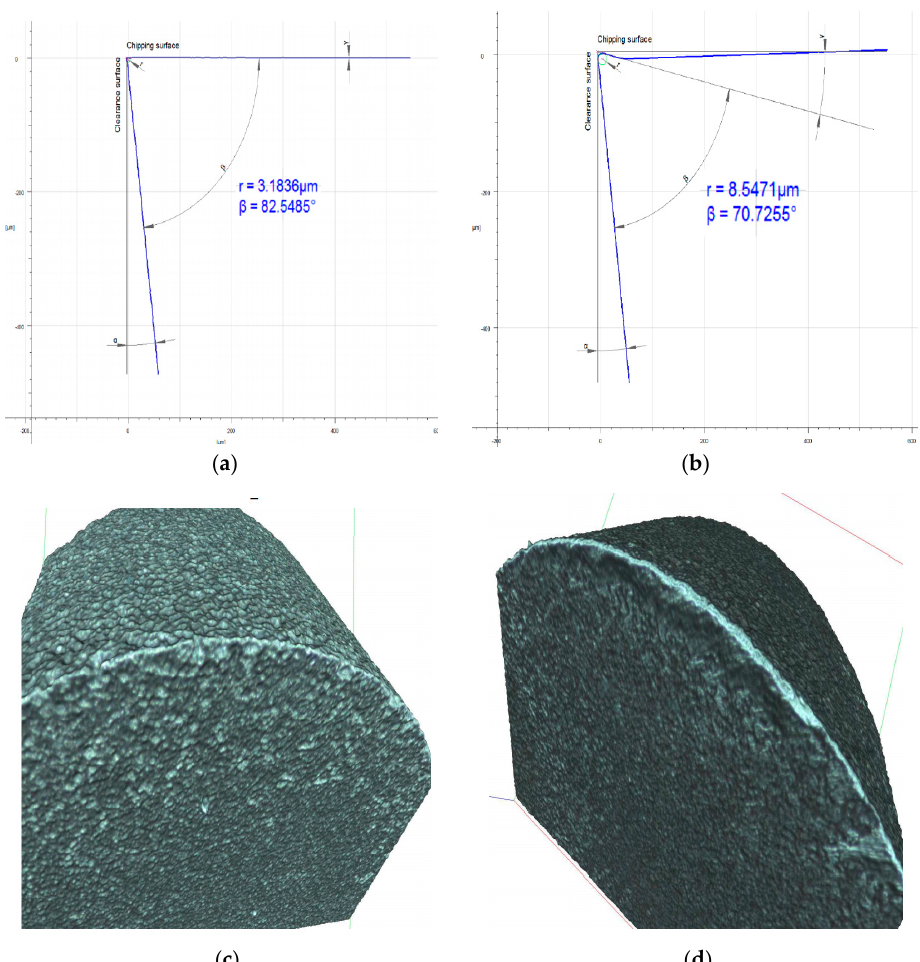
Figure 15. ( a ) Sample of measuring the angle of the cutting edge on insert before use; ( b ) Measuring the angle of the cutting edge of the insert after use (angle changed due to BUE); ( c ) 3D figure of the new insert before use; ( d ) 3D figure of the used insert with BUE.